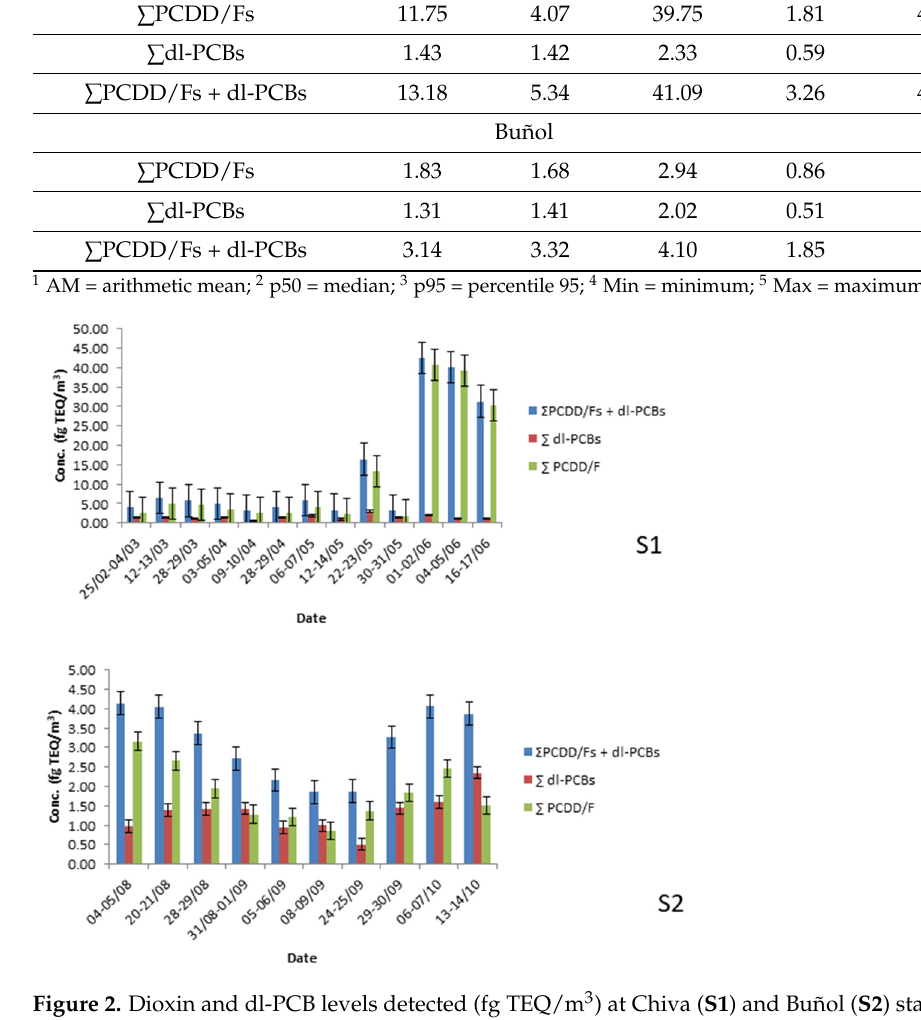
Figure 2. Dioxin and dl-PCB levels detected (fg TEQ/m 3 ) at Chiva ( S1 ) and Buñol ( S2 )